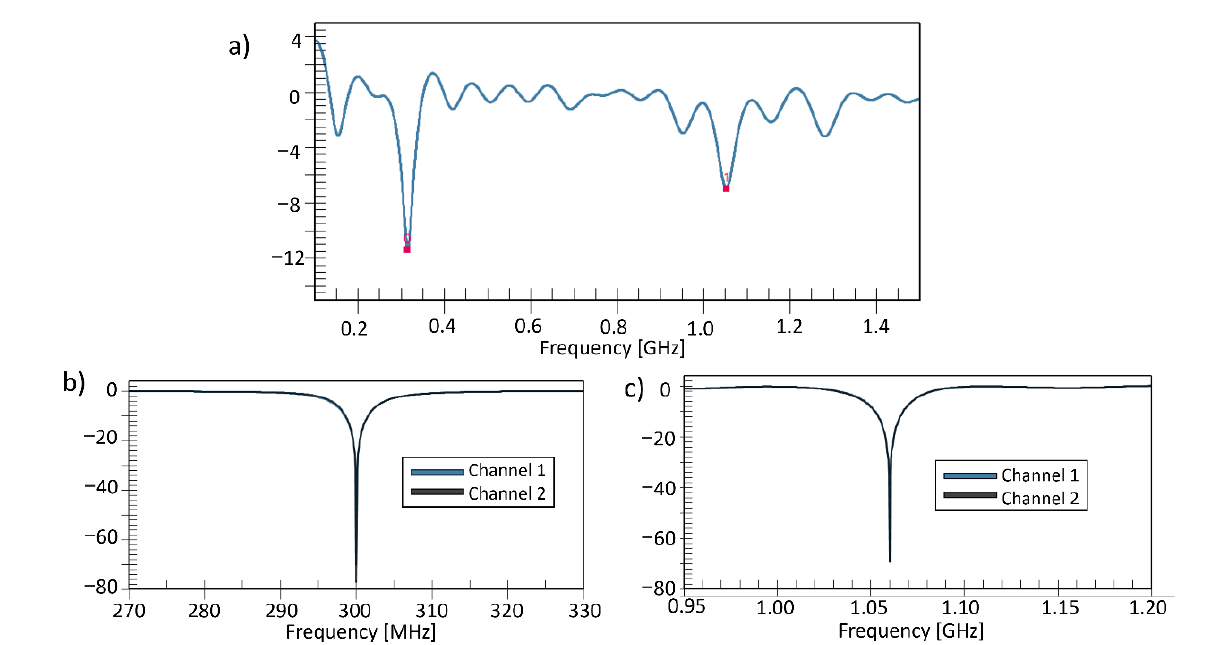
Figure 5. The S 11 parameters of the proposed patch antenna, ( a ) with two main resonance frequencies of 300 MHz and 1.06 GHz. performed 50 ohm matched ( b ) at 300 MHz and ( c ) at 1.06 GHz each of two proposed patch antennas.